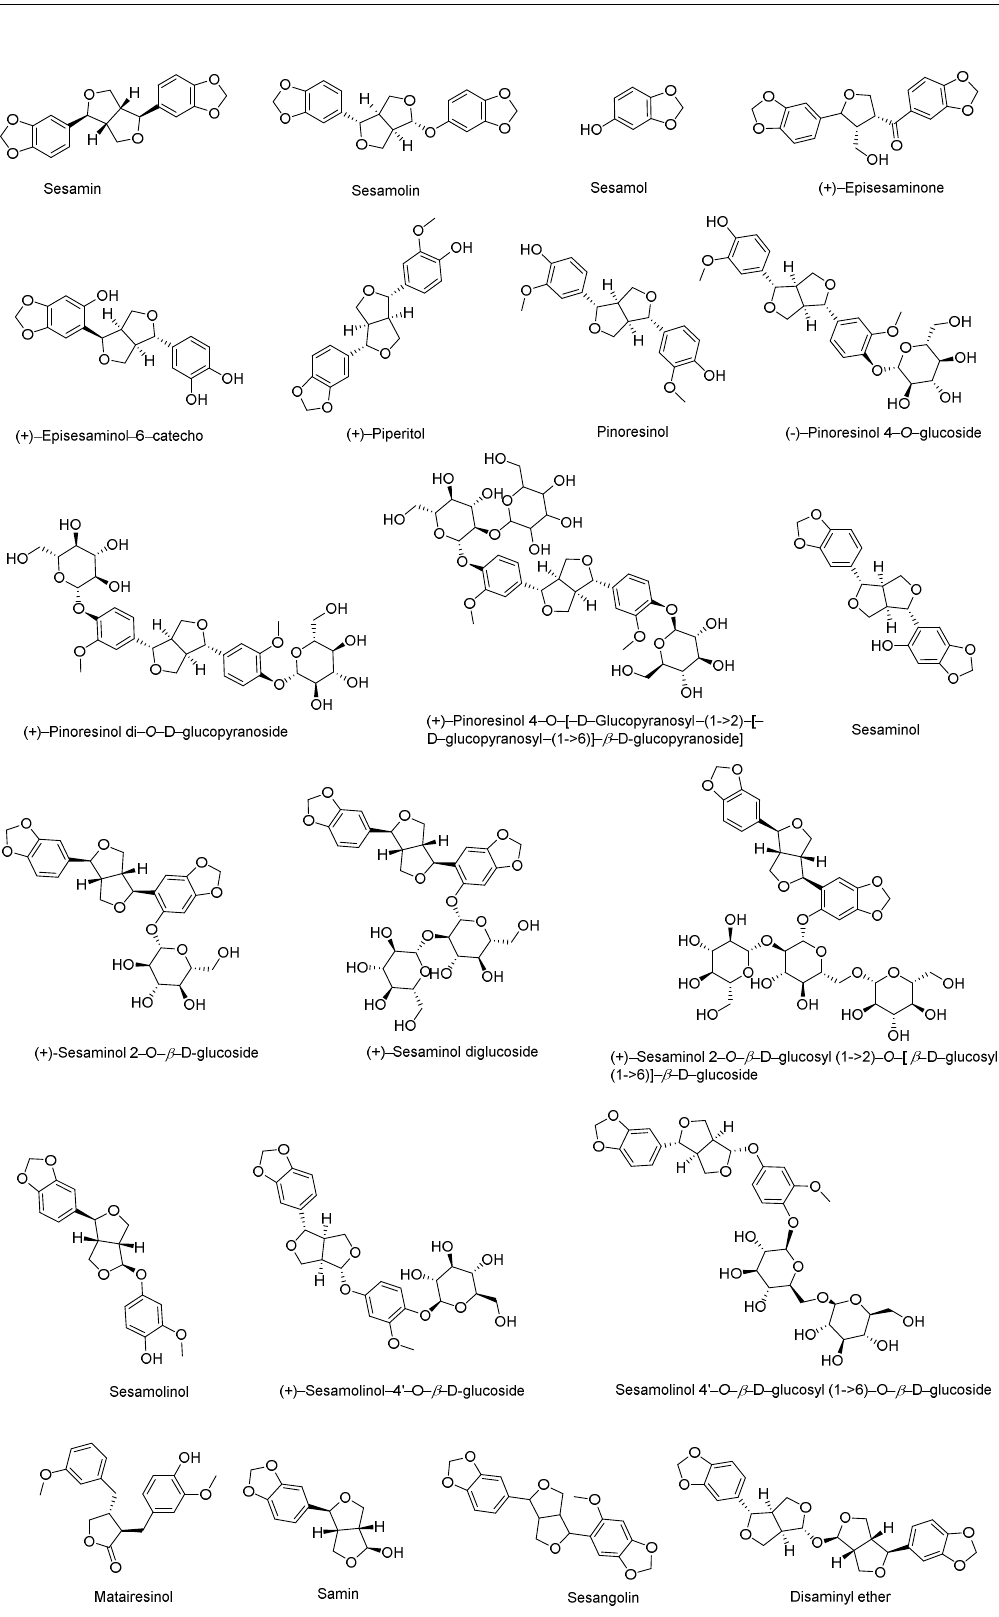
Figure 3. The reported chemical structures of lignans in sesame.